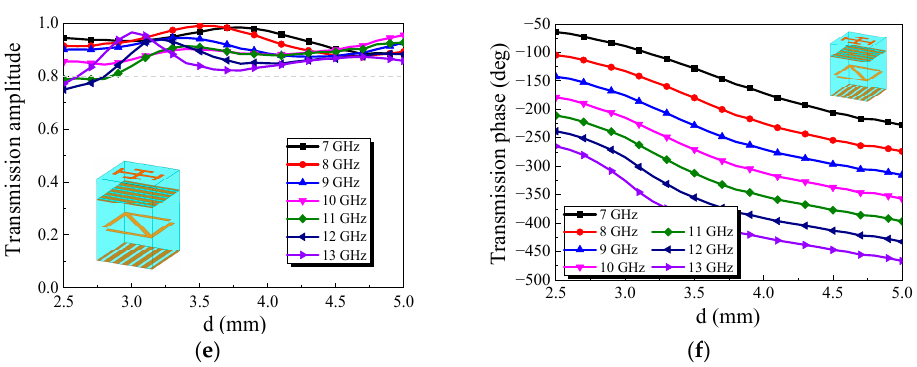
Figure 6. Simulation results of transmission performance: ( a ) transmission amplitude when l 3 = 2 mm; ( b ) transmission phase when l 3 = 2 mm; ( c ) transmission amplitude of the arrow rotated 90°; ( d ) phase comparison before and after arrow rotation at 10GHz; ( e ) transmission amplitude when l 3 = 3.9 mm; ( f ) transmission phase when l 3 = 3.9 mm.